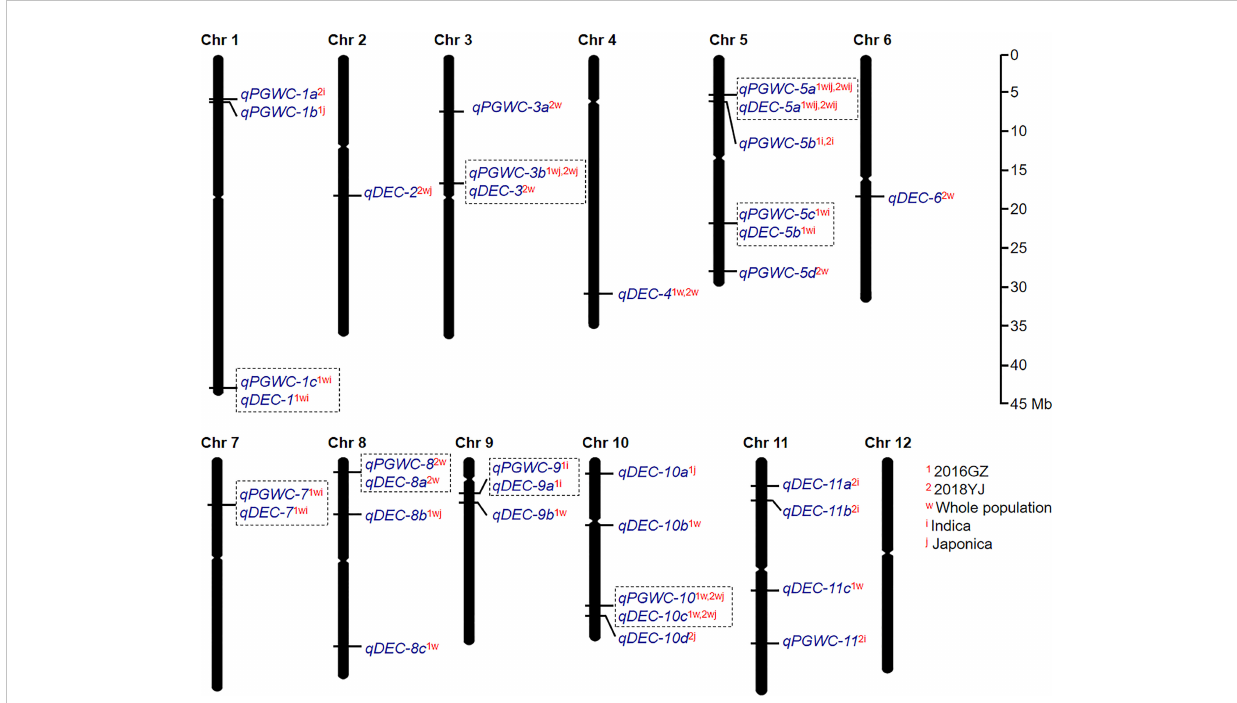
FIGURE 2 The global view of QTL mapping for PGWC and DEC by GWAS. The co-located QTLs were surrounded with dotted boxes. The superscript letters (1 and 2) refer to the two environments (2016GZ and 2018YJ, respectively). The superscript letters (w, i and j) refer to the three populations (whole, indica and japonica , respectively). For example, qDEC-10c 1w,2wj indicates that qDEC-10c can be identi fi ed in 2016GZ by the whole population and in 2018YJ by the whole and japonica